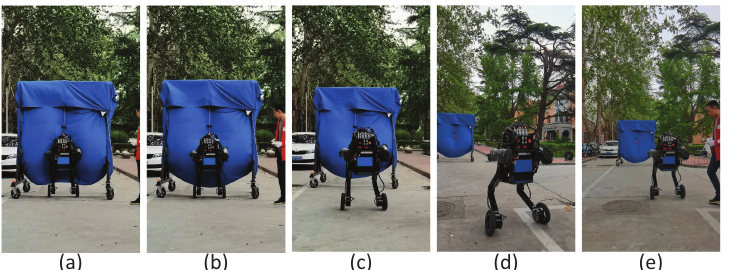
Figure 14. Snapshots of the physical test for velocity tracking. Photos ( a – d ) show the forward movement of the robot following a given trajectory. Photos ( d , e ) show the process of the robot moving backward due to position